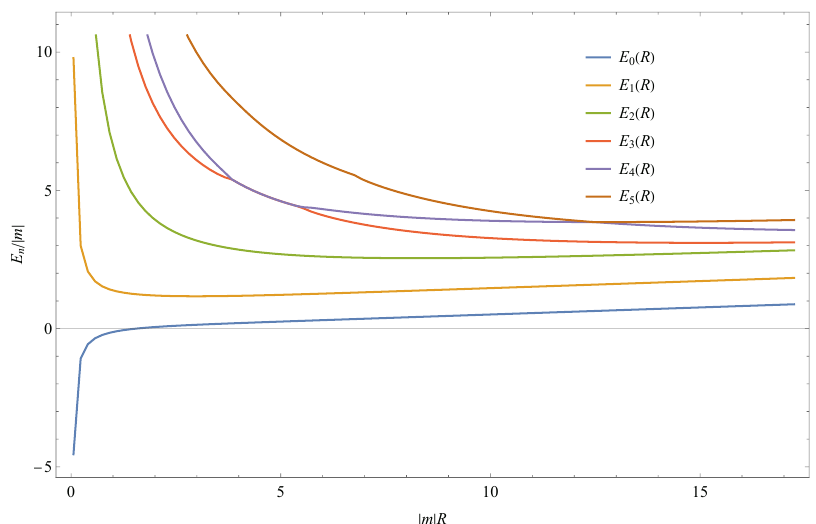
. One can observe nonvanishing 0